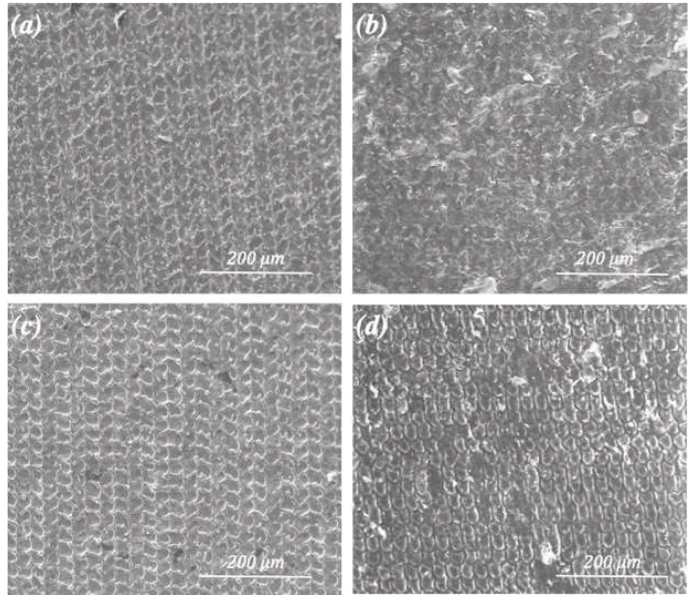
Figure 6. Surface topography of Titanium at ( a ) 1250 mm/s and 40 J/cm 2 and ( c ) 1250 mm/s and 50 J/cm 2 used for the replica on PA22000 ( b ) and ( d ), respectively.